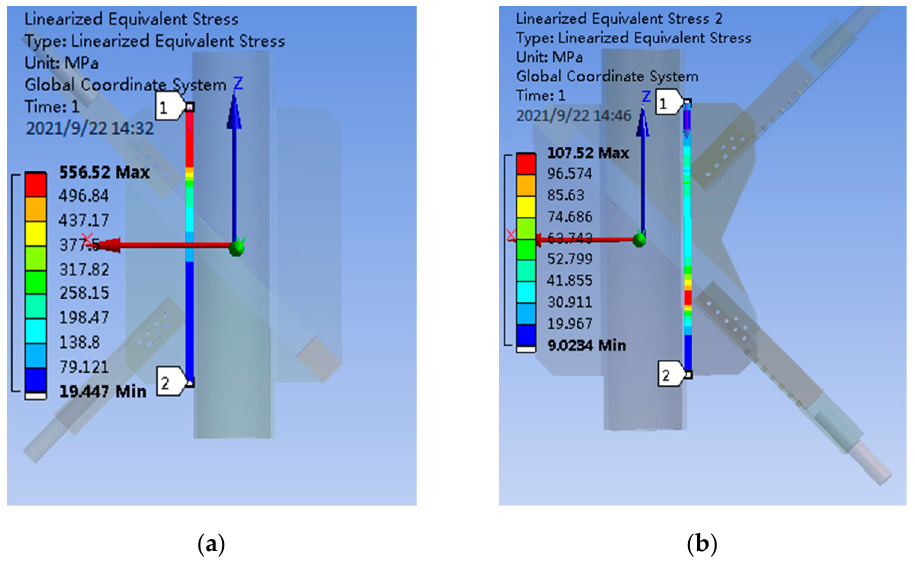
Figure 9. ( a ) End stress of plate of PSLSPJ; ( b ) end stress of plate of PDLDPJ.